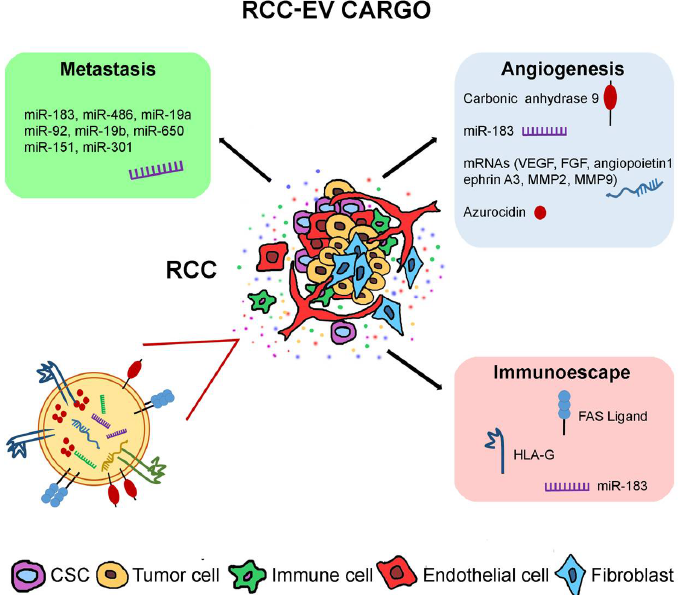
Figure 1. RCC-EV cargo. Molecules carried by RCC-EVs are described to play a role in tumor progression through the promotion of angiogenesis, metastasis formation and immune